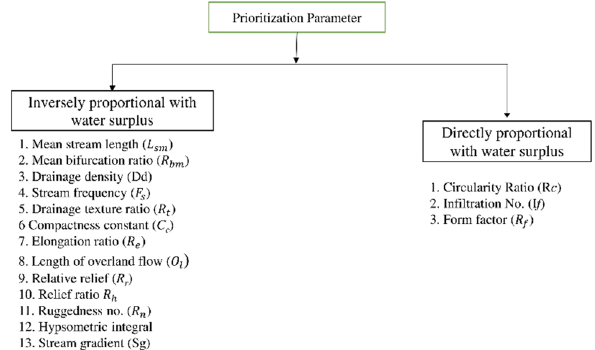
Fig. 8 Morphometric parameter used for sub-watershed prioritization and their relation with water surplus